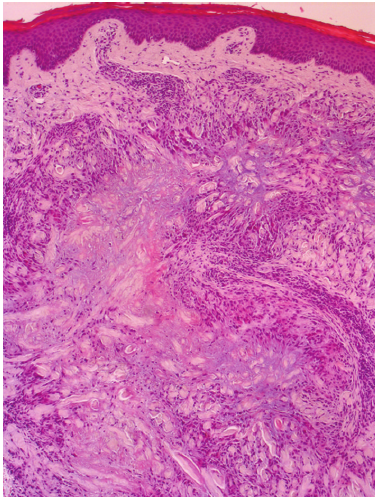
Figure 4: Normal epidermis. Palisaded granulomas of dermis with epithelioid histiocytes around a central zone of mucin (haema- toxylin